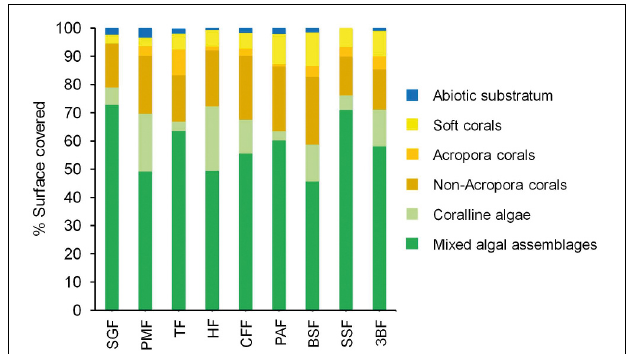
FIGURE 6 | Contribution of benthic communities to the coverage of the substratum (expressed in % of total surface) onto the reef slope at 10-m depth (corresponding to fore reef samples n ◦ 4) from north (SGF) to south